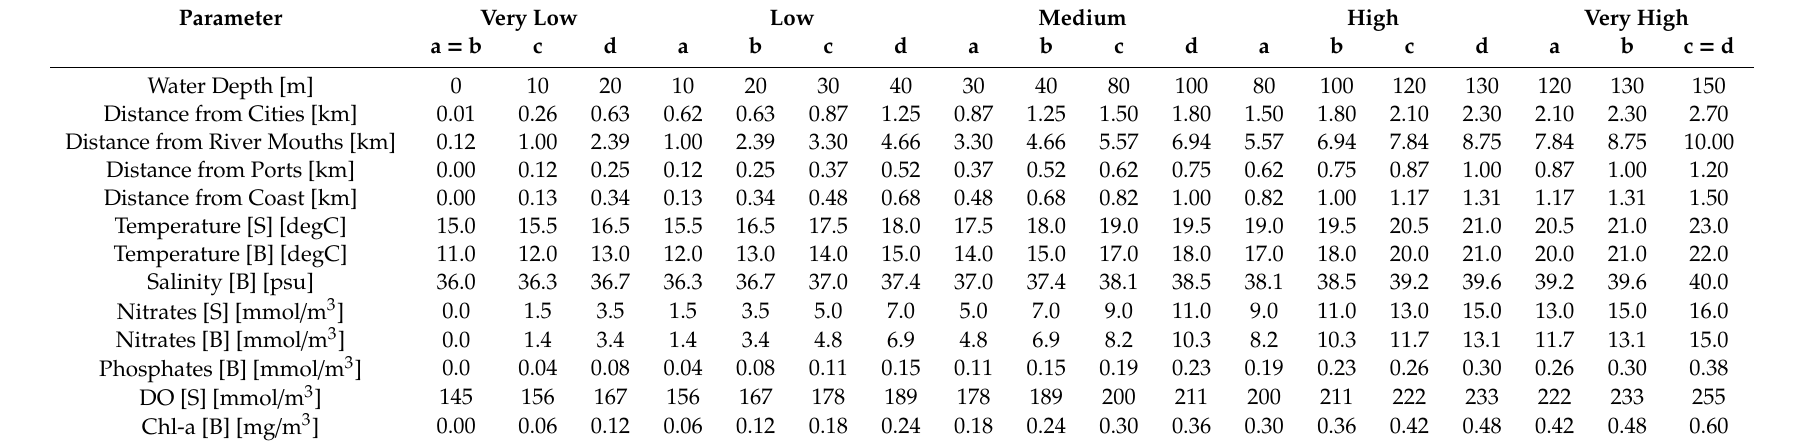
Table 3. Parameters for membership functions used in the fuzzy inference system. S and B represent surface and bottom values, respectively. Parameter Very Low